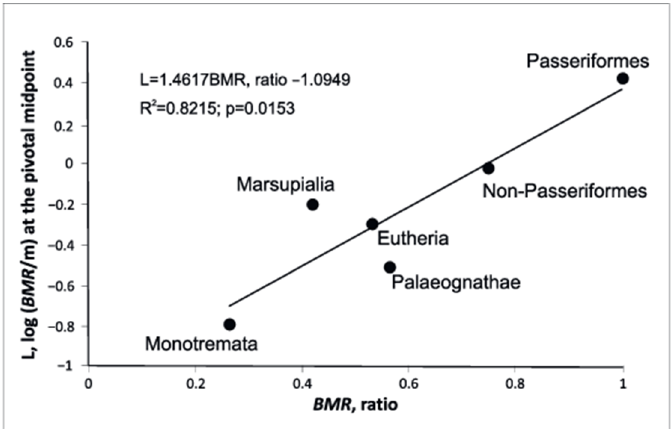
Figure 3. Relationship between scaling elevation, L and the dimensionless ratio of BMR.